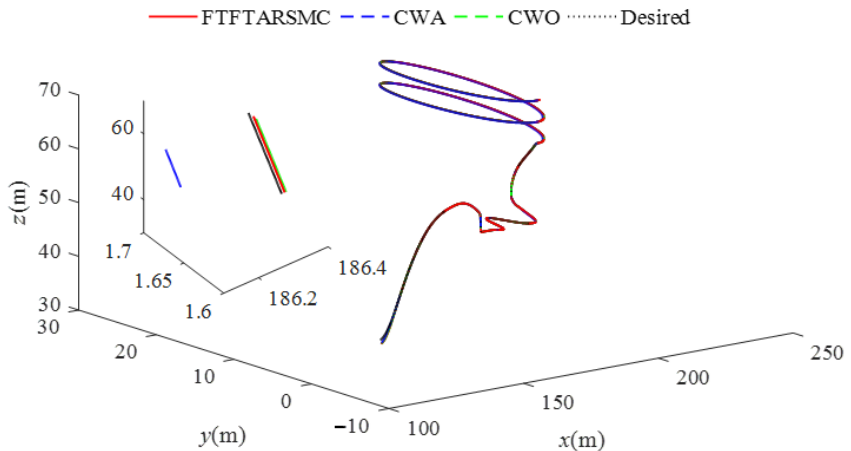
Figure 12. Trajectory tracking of the S-AUV.